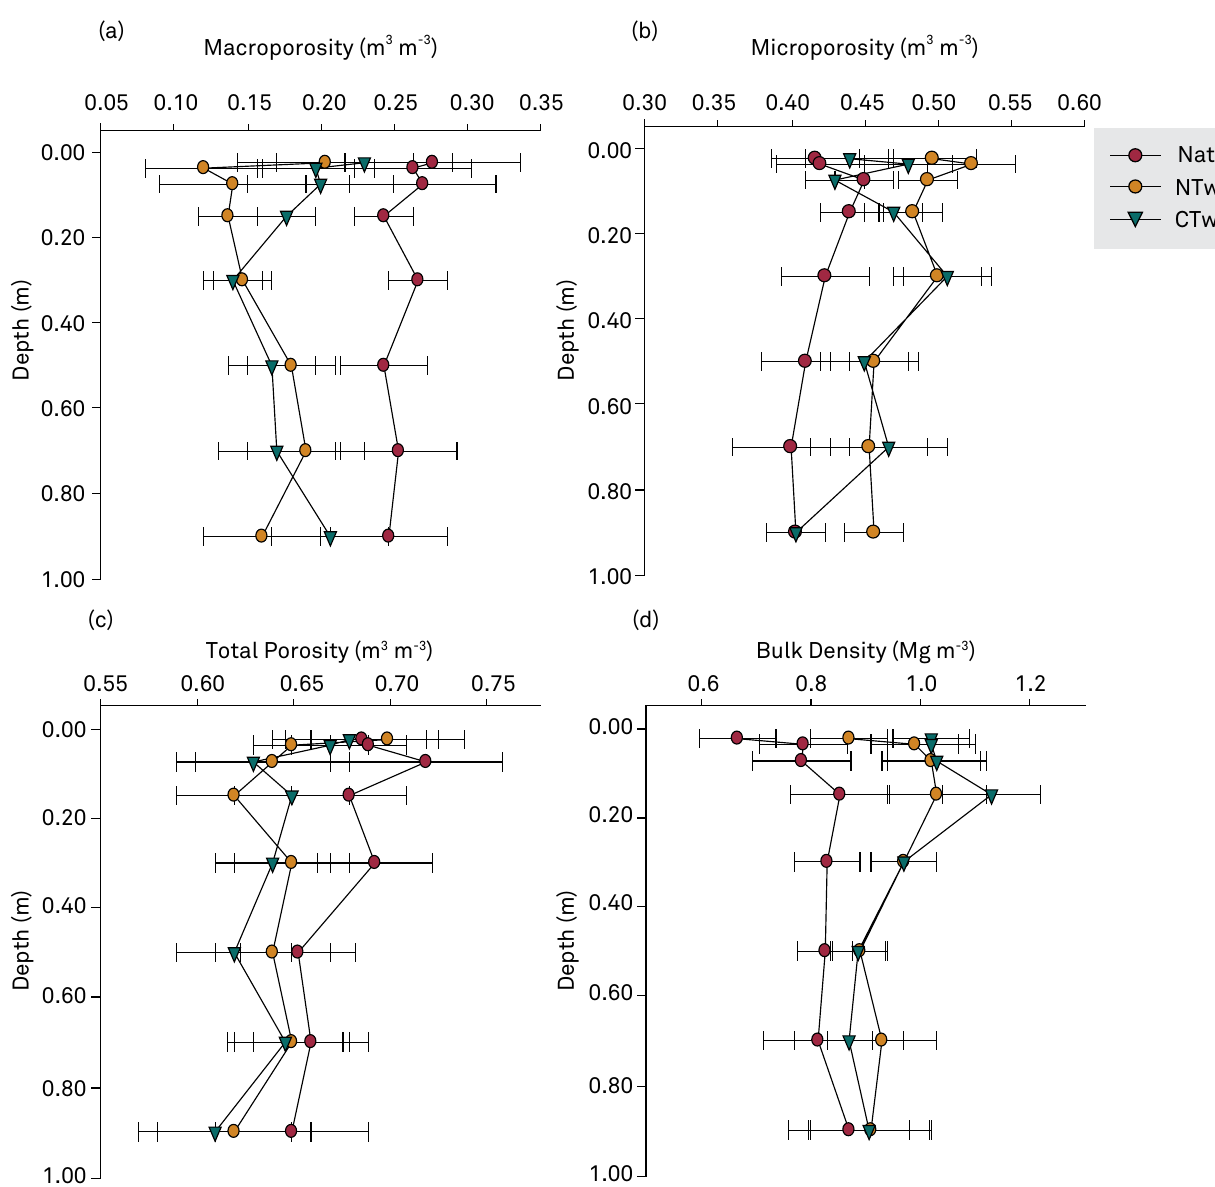
Figure 1. Macroporosity (a), microporosity (b), total porosity (c), and bulk density (d) in a Latossolo Bruno Alumínico típico (Hapludox) subjected to different tillage systems and liming methods. Horizontal bars indicate the interval of least significant difference for the t test and their overlap in the same soil layer means the absence of difference between the averages of the systems. CTwl: conventional tillage without lime; and NTwl: no-tillage without